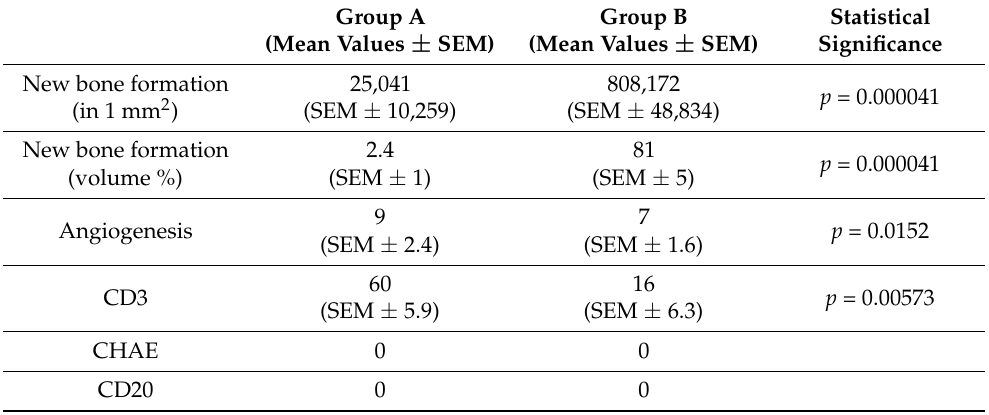
Table 1. Histopathological evaluation of the temporal bone, comparing group A and group B.